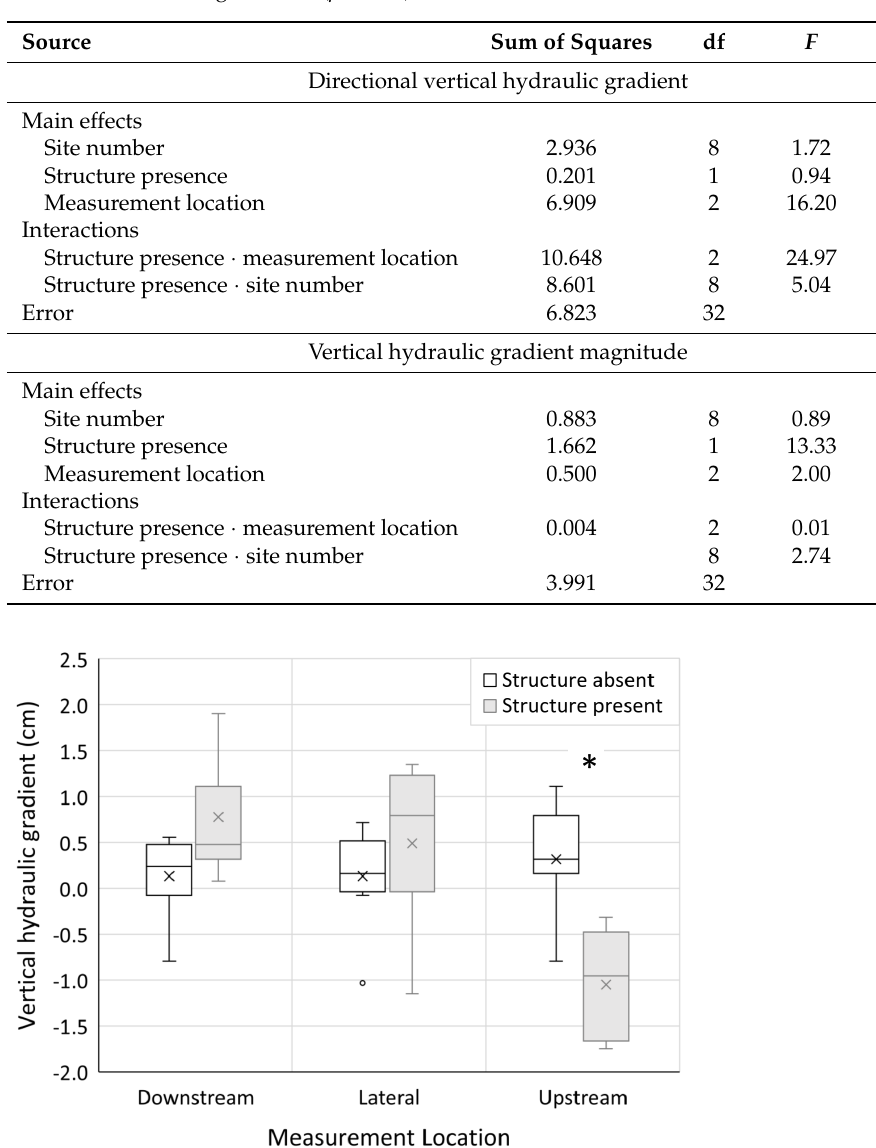
Table 3. Three-way analysis of variance results of vertical hydraulic gradient on the lower Mokelumne River. The effects of site number (1–9), in-channel structure presence (Yes versus No), measurement location (upstream, lateral, and downstream) and interactions of the main effects were tested. Bold indicates statistical significance ( p < 0.05).